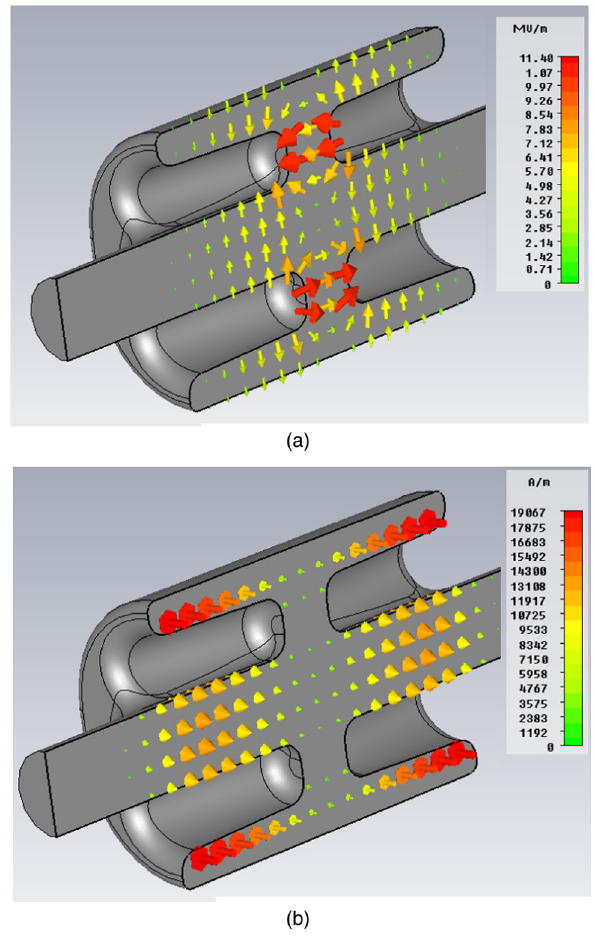
FIG. 1. Electric (a) and magnetic (b) fields (arbitrary units) in a